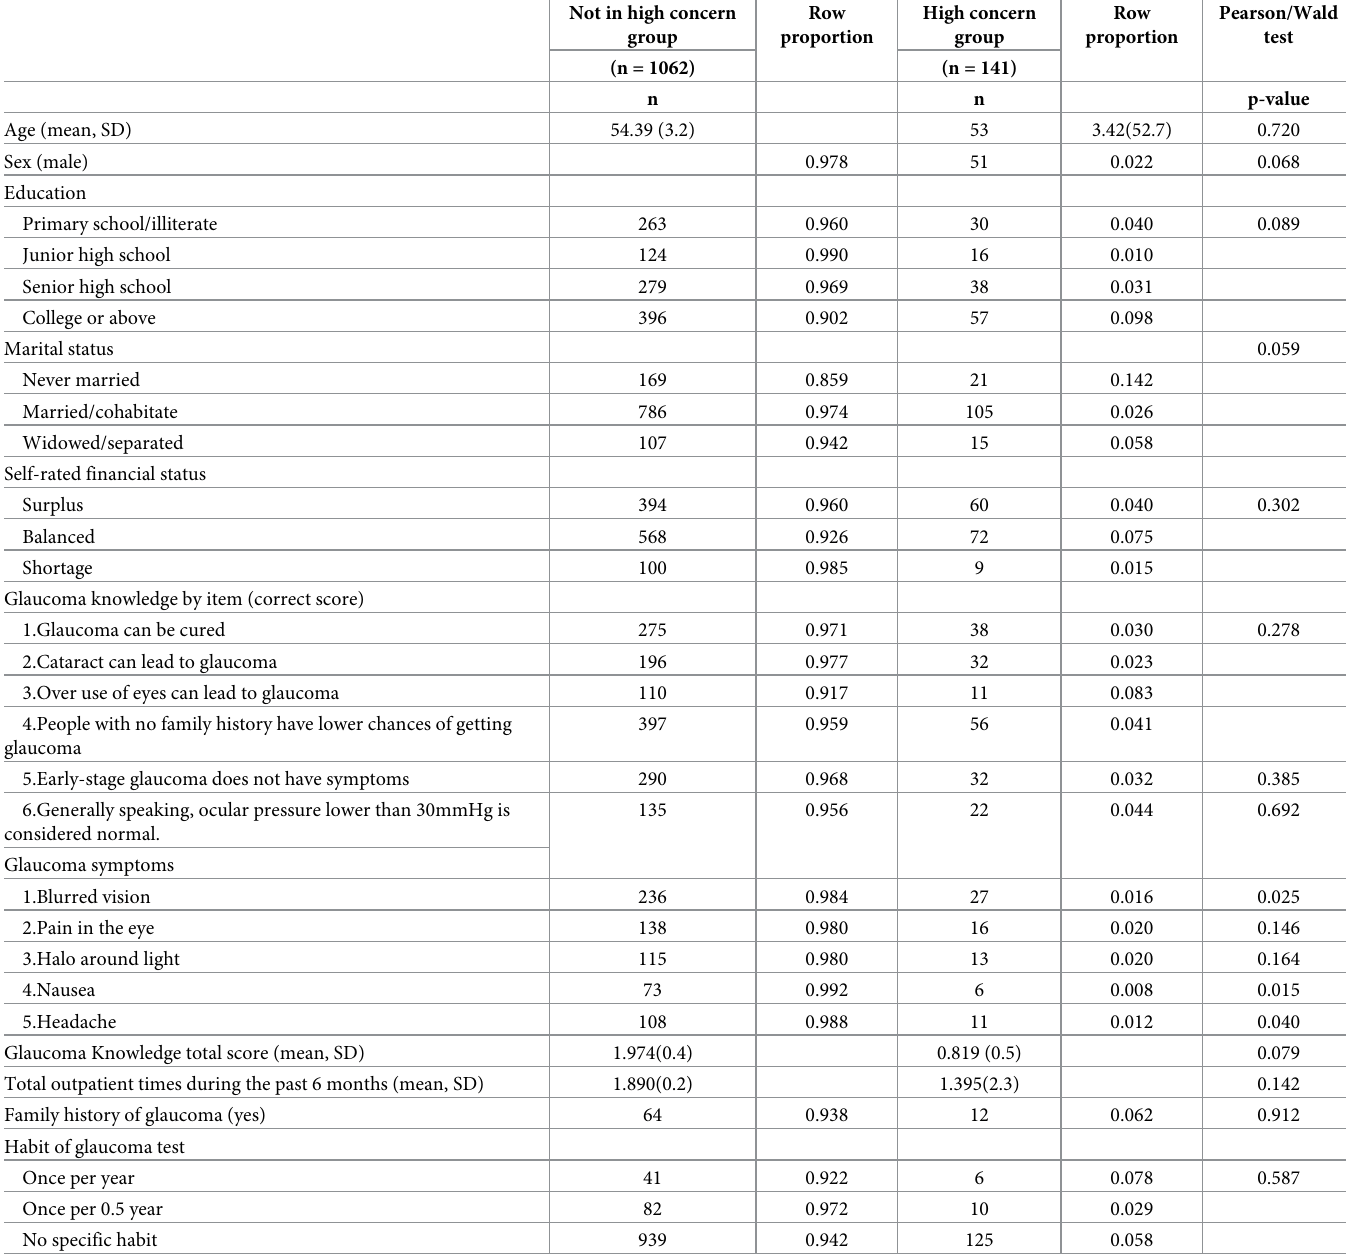
Table 2. Weighted sample characteristic (n =